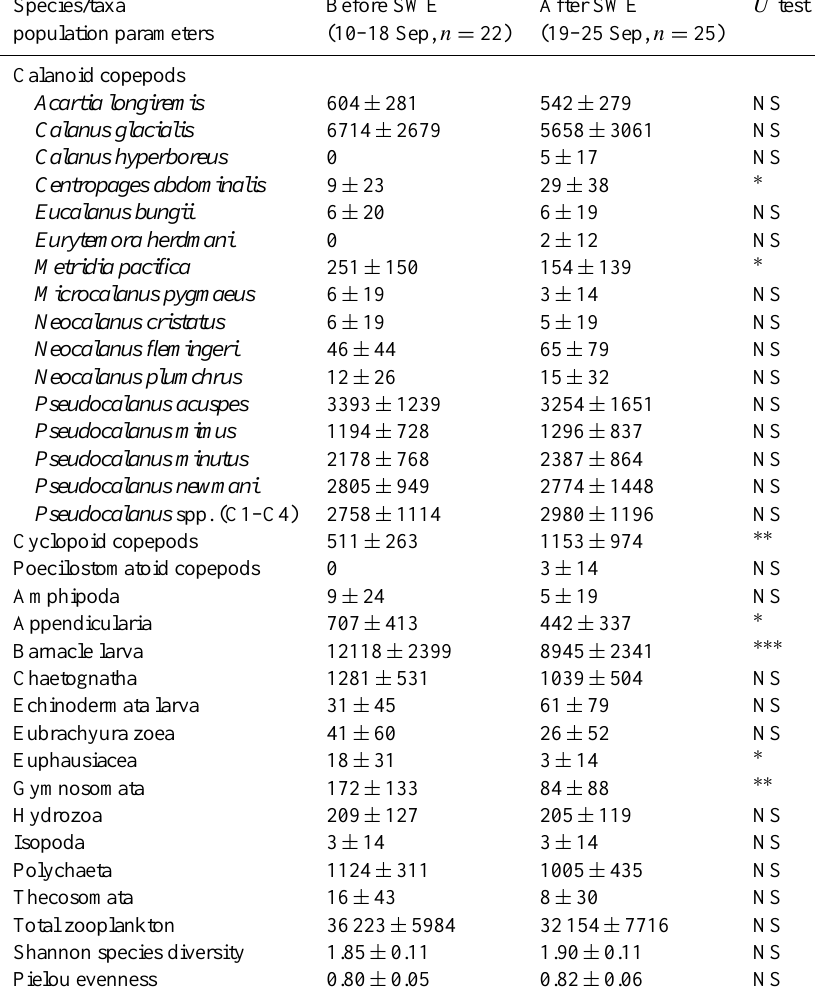
Table 1. List of mesozooplankton taxa and calanoid copepod species and their mean abundances (ind.m − 2 ) at a fixed station in the Chukchi Sea from 10 to 18 September 2013 (before the strong wind event, SWE) and 19 to 25 September 2013 (after the SWE). Values are mean ± 1SD. For calanoid copepods, Shannon species diversity and Pielou evenness were calculated. Differences between the two peri- ods (before vs. after the SWE) were tested with the U test. ∗ p < 0 . 05; ∗∗ p < 0 . 01; ∗∗∗ p < 0 . 0001; NS: not